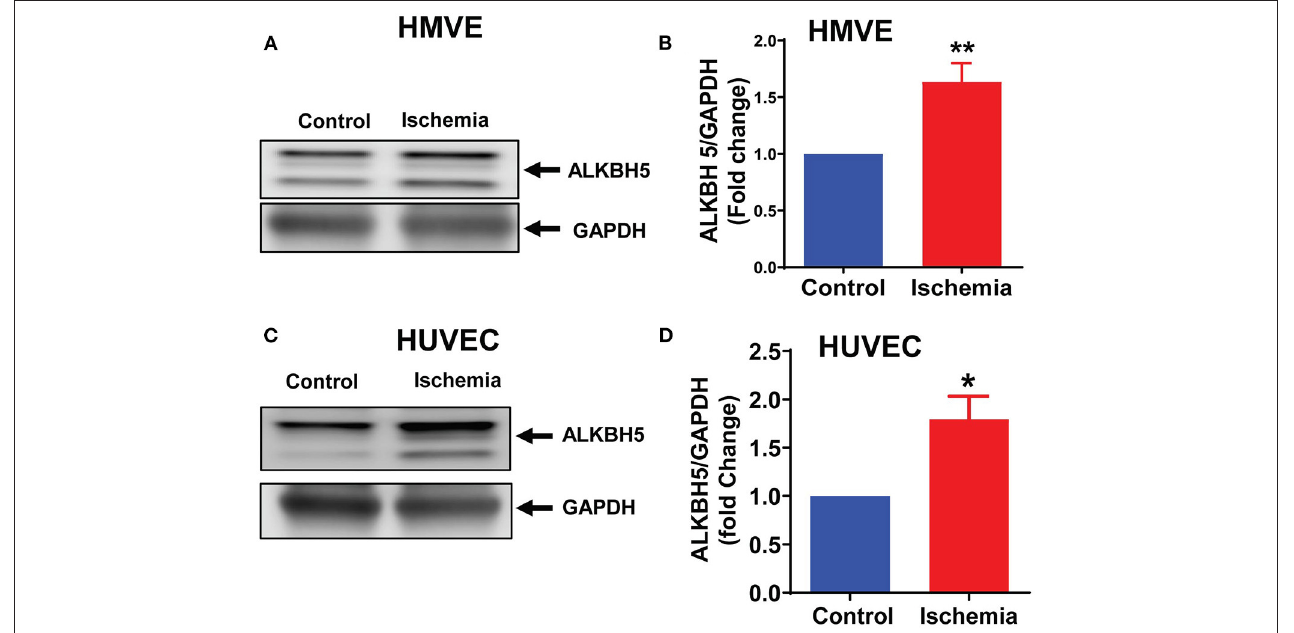
FIGURE 1 | Ischemic stress increased ALKBH5 expression. HMVE and HUVEC cells were treated with ischemic stress for 24 h. Proteins were isolated for western blotting (WB). WB is showing protein expression of ALKBH5 in HMVE (A,B) , HUVEC (C,D) . Increased AKLBH5 expression was observed following ischemic stress in both human endothelial cells lines. ** P < 0.01, control vs. 24h ischemia, * P < 0.05, control vs. 24h ischemia ( n = 3–5).